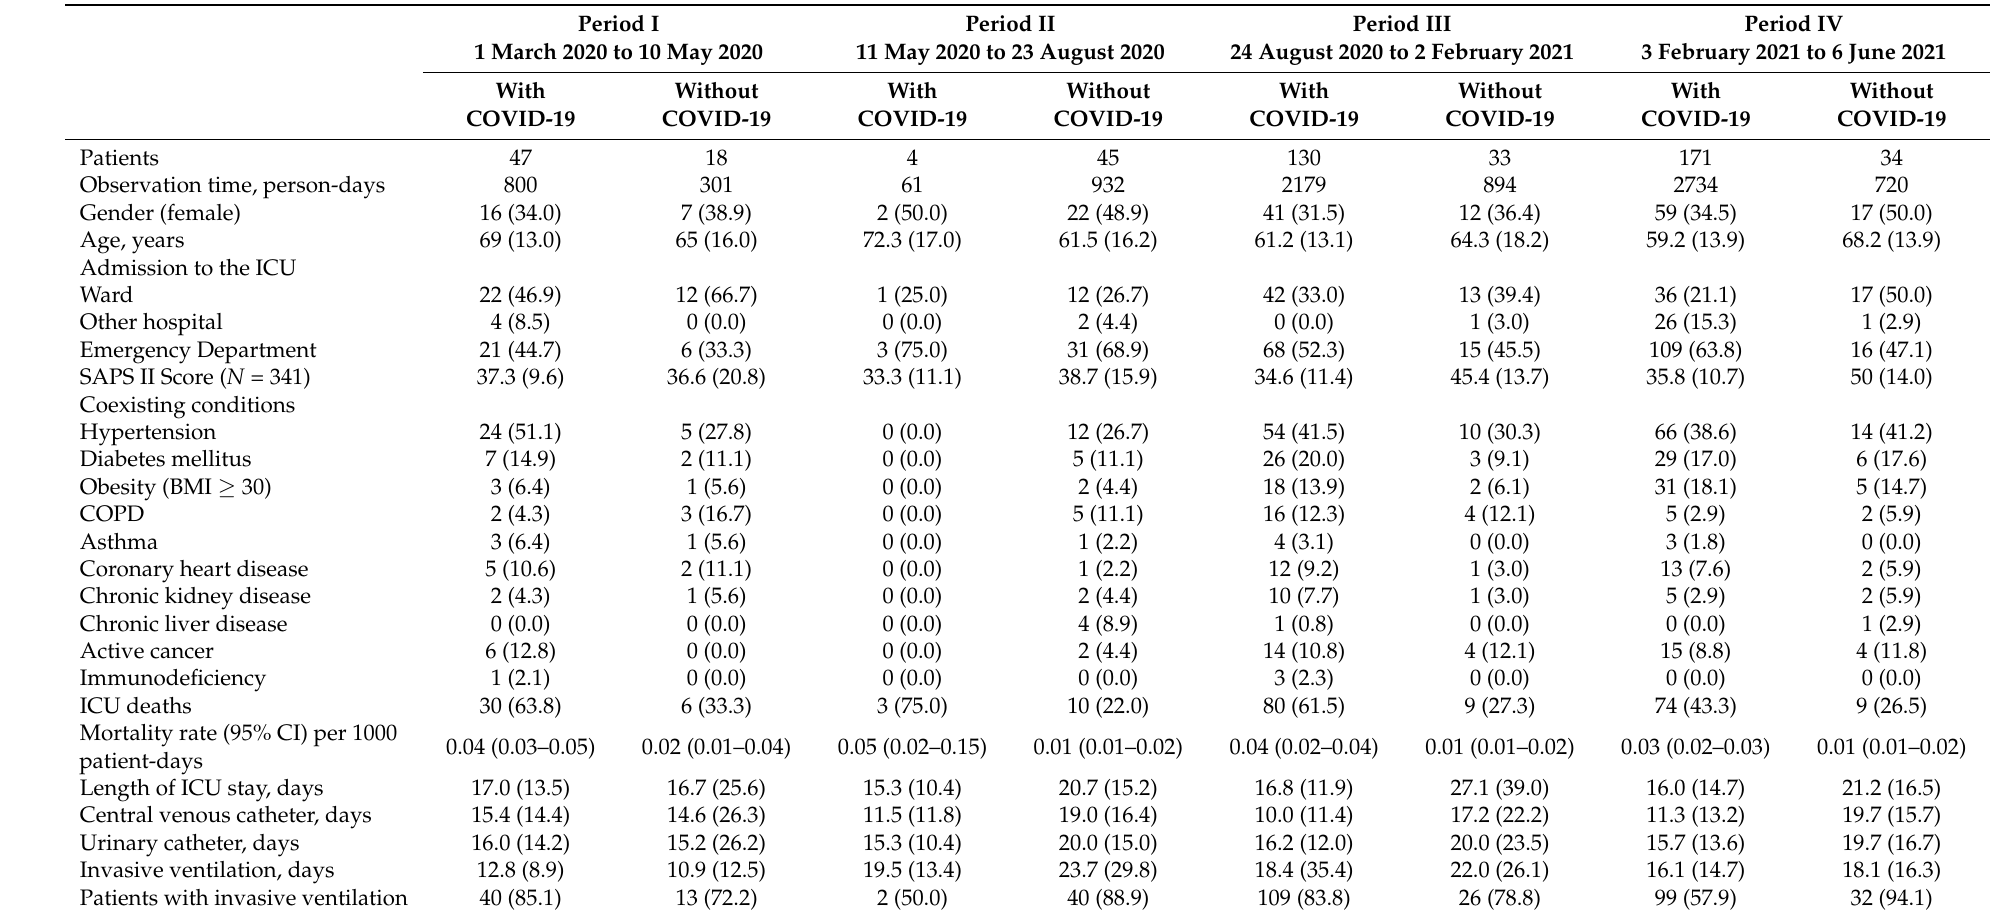
Table 1. Characteristics of the patients admitted to the Intensive Care Unit (ICU) of Umberto I teaching hospital of Rome between 1 March 2020 and 6 June 2021 by study period. Results are expressed as number (percentage) or mean (standard